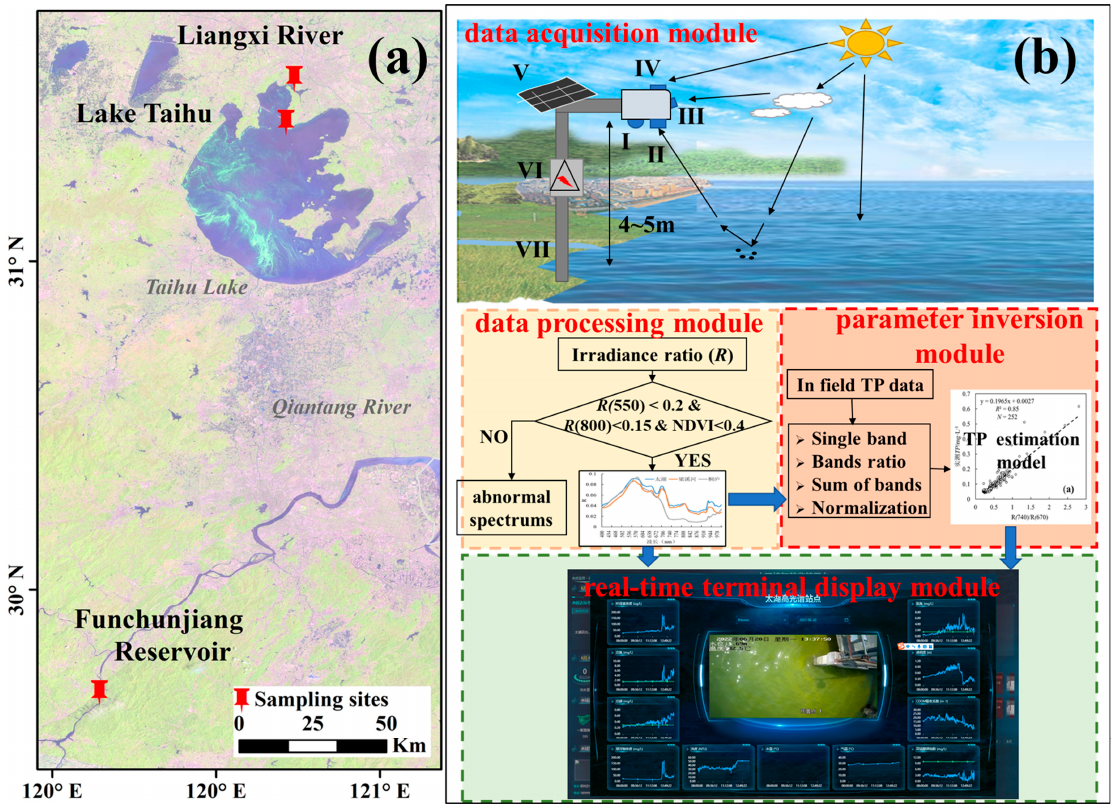
Figure 1. Location of three monitoring sites ( a ); the framework of the GHPSs and workflow of real-time observation for TP ( b ) (I. high-definition video monitoring; II. lower spectrometer; III. ambient light sensor; IV. upper spectrometer; V. solar panel; VI. power and data storage; VII.